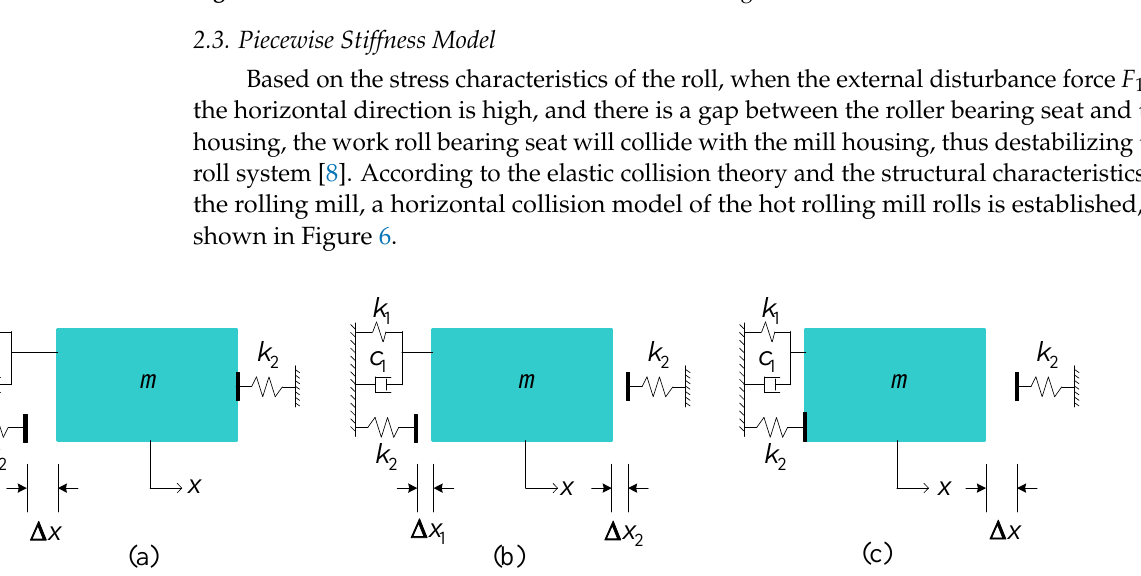
(5) Figure 7. Piecewise stiffness force function of hot rolling mill rolls in the horizontal direction. 3. Dynamic Rolling Force Model of Hot Rolling Mill Rolls 3.1. Determination of Rolling Parameters in Deformation Zone During rolling, the rolling force is an important factor affecting the vibration of the rolling mill [25,26]. It is important to determine the rolling force correctly to improve the accuracy of the rolling mill vibration model. Figure 8 shows the dynamic deformation process of the workpiece in the rolling process. -2